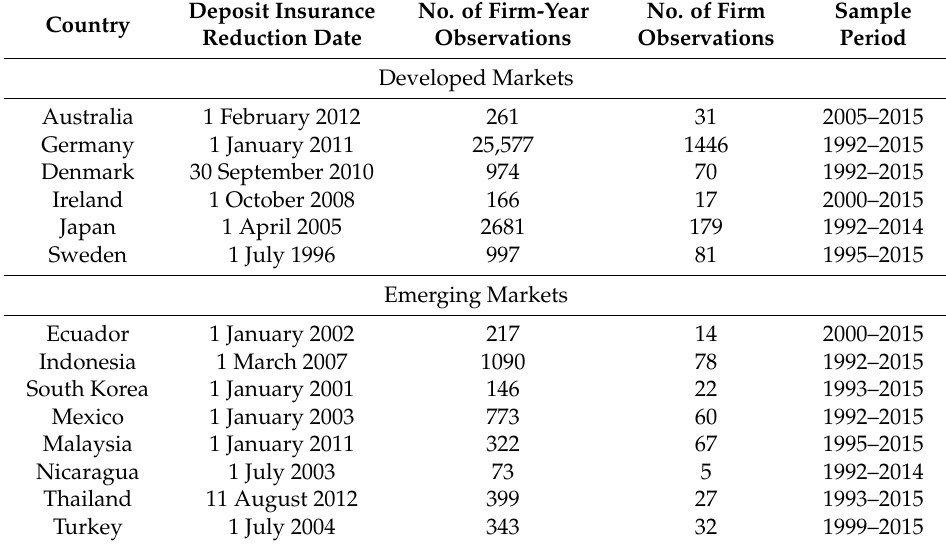
Table 1. Deposit Insurance Reduction